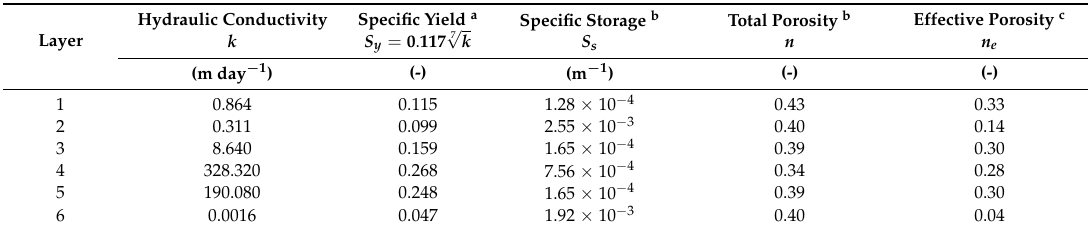
Table 1. Hydrogeological parameters of model layers.